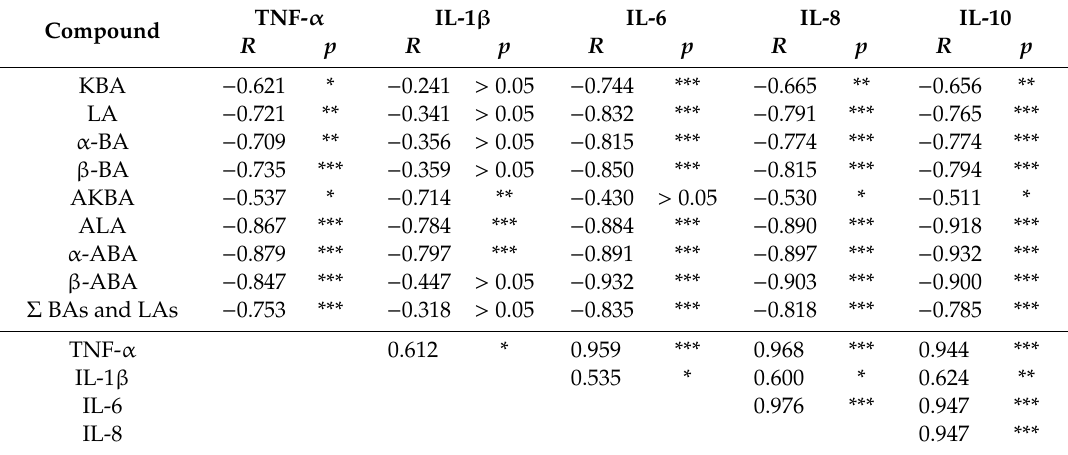
Table 2. Correlation between BAs and LAs contents and inhibition of cytokine production by LPS-stimulated